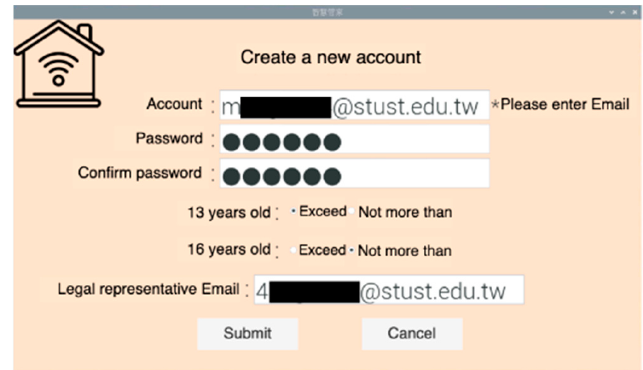
Figure 11. Interface of account creation under the age of 16.